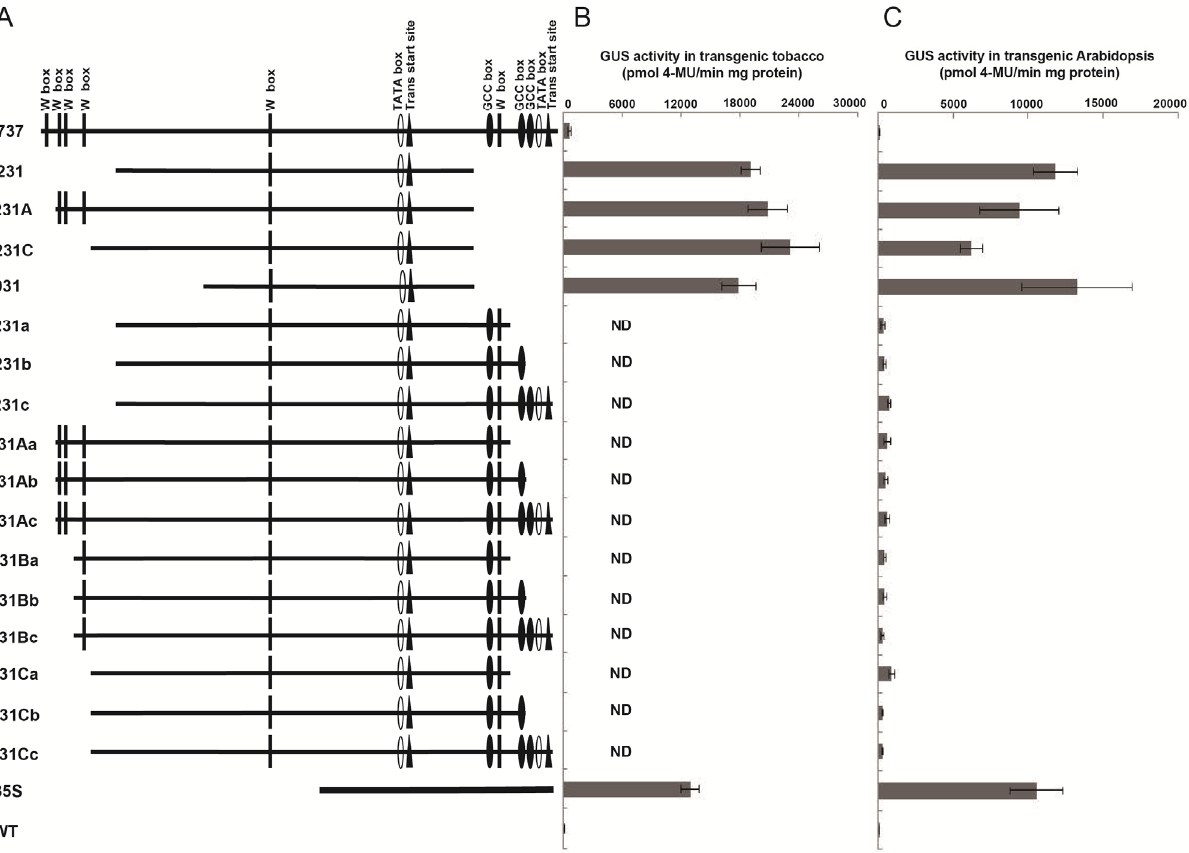
Figure 4. The finely truncated Wip1 promoters and their activity in transgenic Arabidopsis and tobacco plant leaves. ( A ) Schematics of the finely truncated Wip1 promoters. The numbers or/and letters in front of each schematic indicate the names of the corresponding constructs; ( B ) The GUS activities of transgenic tobacco plants. Error bars represent the S.E of n independent transgenic lines, n = 8 for 1737, 1231 and 35S; n = 18 for 1231A, 1231C and 931; n = 3 for WT. ND indicates not determined; and ( C ) The GUS activities of transgenic Arabidopsis plants containing different constructs. Error bars represent the S.E. of n independent transgenic lines, n = 3 for WT, and n = 6 for the